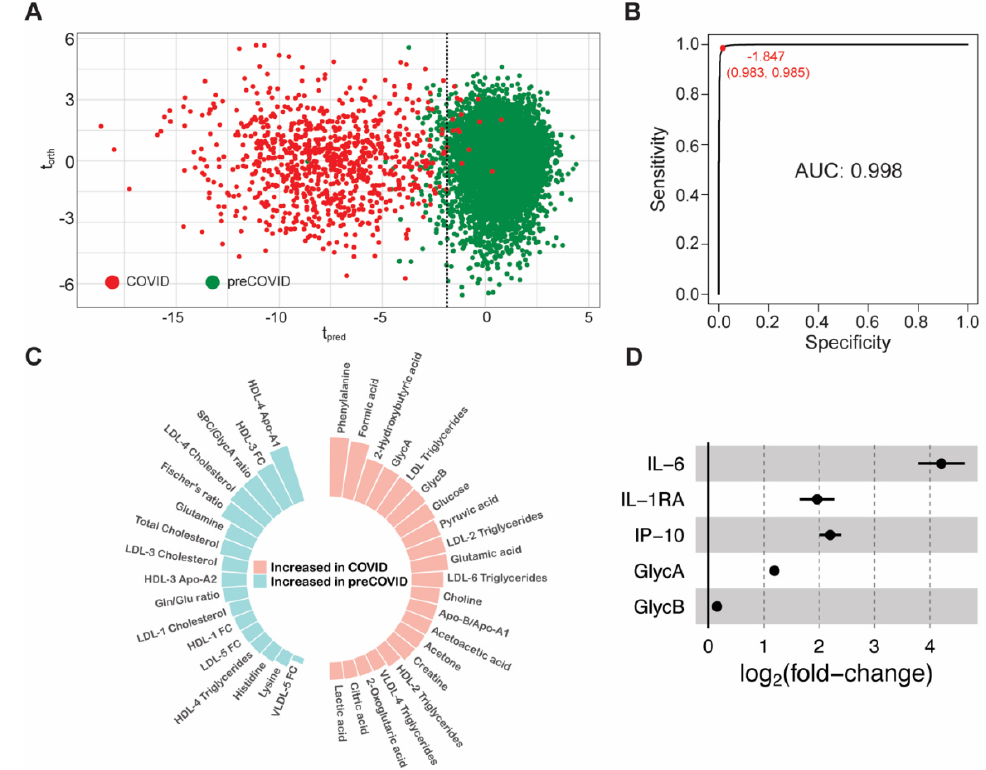
Figure 2. ( A ) Score plot from O-PLS-DA model that discriminates between COVID-19 patients (red circles, AC0 and AC1 cohorts) and healthy individuals (green circles, HC cohort). Dashed line corresponds to the value that maximizes Youden’s index. ( B ) Receiver operating characteristic curve for the O-PLS-DA model shown in Figure 2A. The area under the curve (AUC) is 0.998. In red it is indicated the t pred value that maximizes the Youden’s index and the resulting specificity and sensitivity between parentheses. ( C ) Circular bar plot with the 38 metabolic parameters used for the discrimination model. The bars are proportional to the weight in the discrimination. ( D ) Forest plot with some inflammation markers under consideration. Filled circles represent statistically significant differences ( p -value < 0.05). Horizontal lines are standard errors.